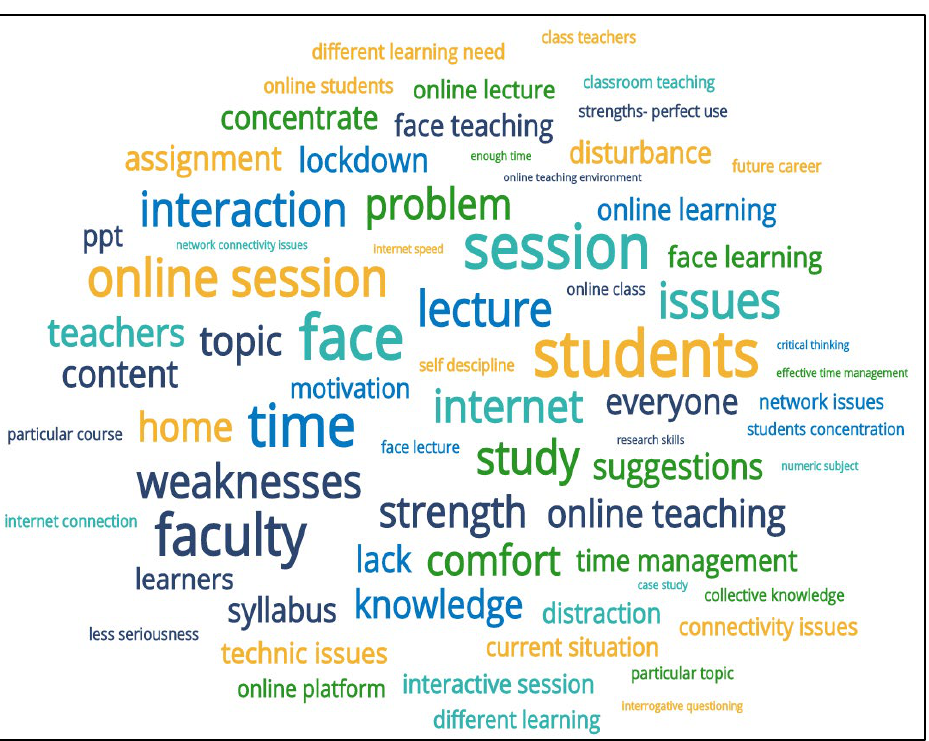
Word Cloud of the Keywords Participants Used Regarding